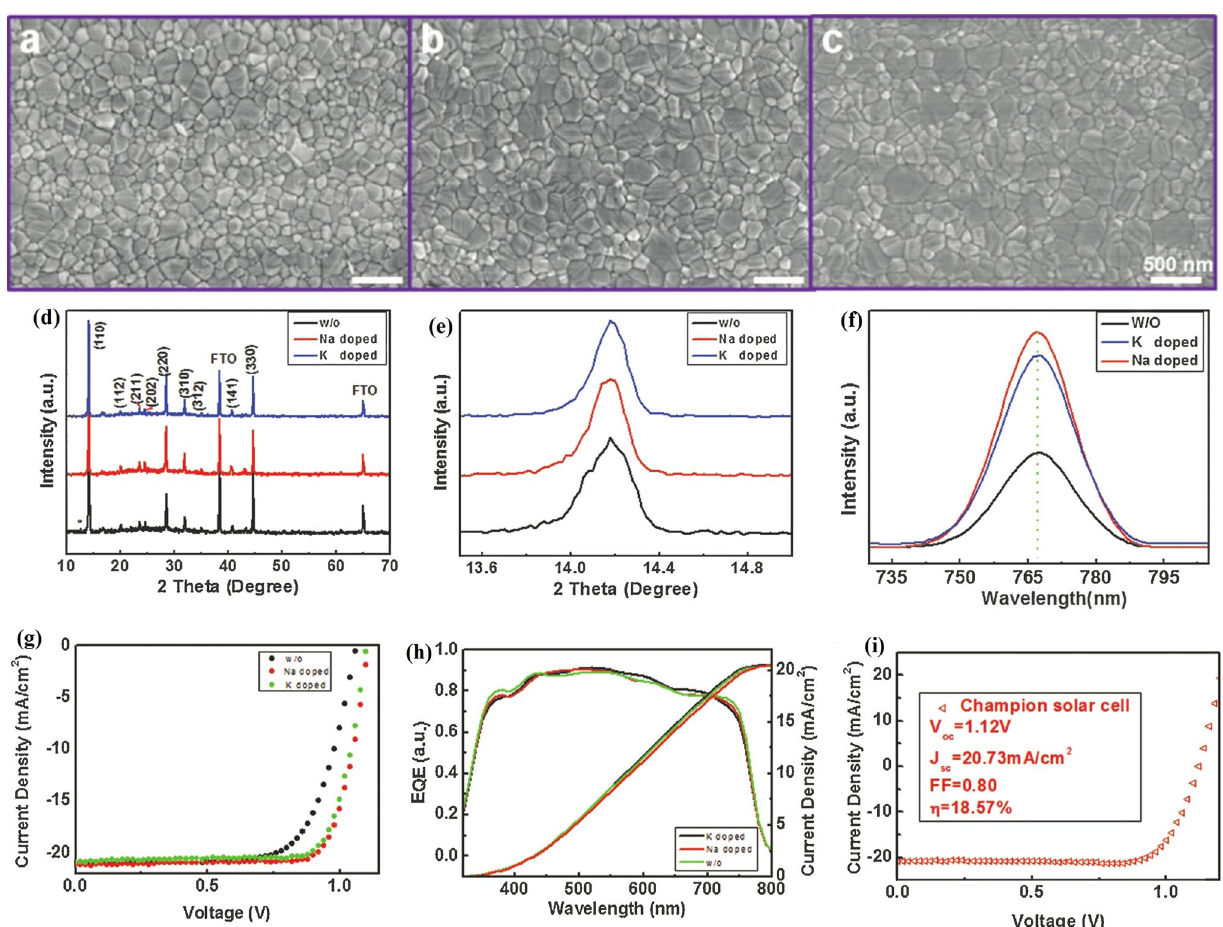
doping i The J–V curve of champion PSCs with 1.0 mol% Na + dop- ing measured at the AM 1.5G solar spectra of 100 mWcm −2 at a reverse scan. Adapted with permission from ref. [70], copyright 2017, WILEY ‐